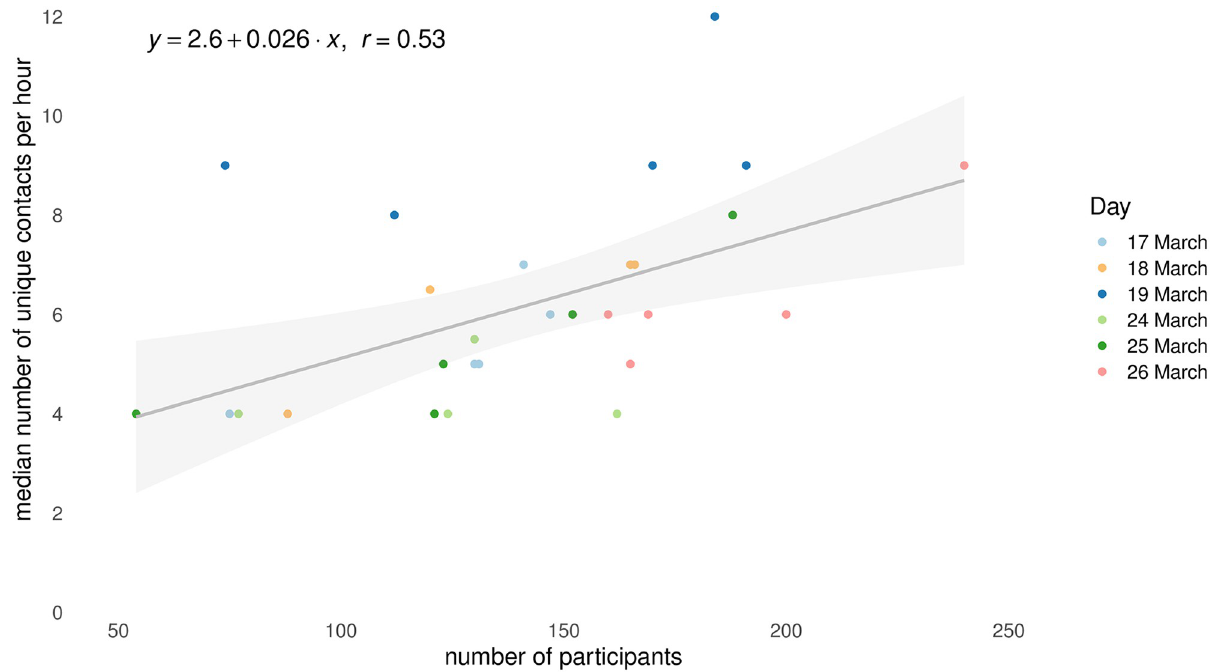
Fig 1. Crowdedness and contacts. Relationship between the number of participants and the median number of unique contacts in one-hour time windows across six days.